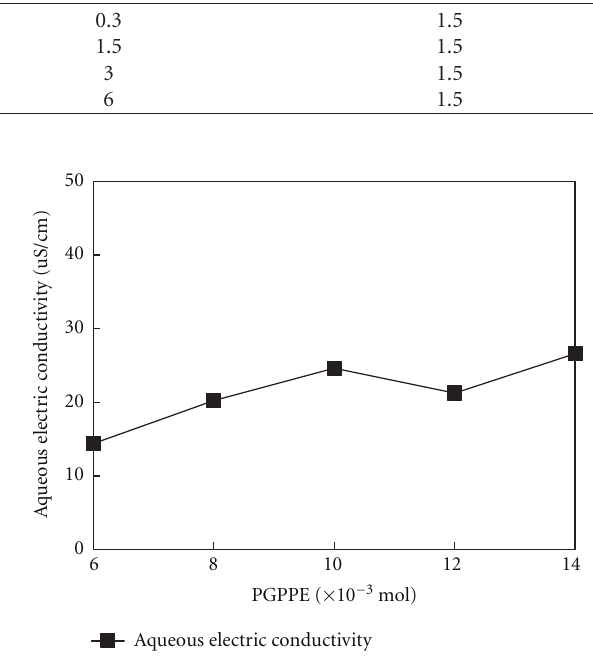
Figure 2: Aqueous electrical conductivity at di ff erent concentra- tions of surfactant without metal ions.